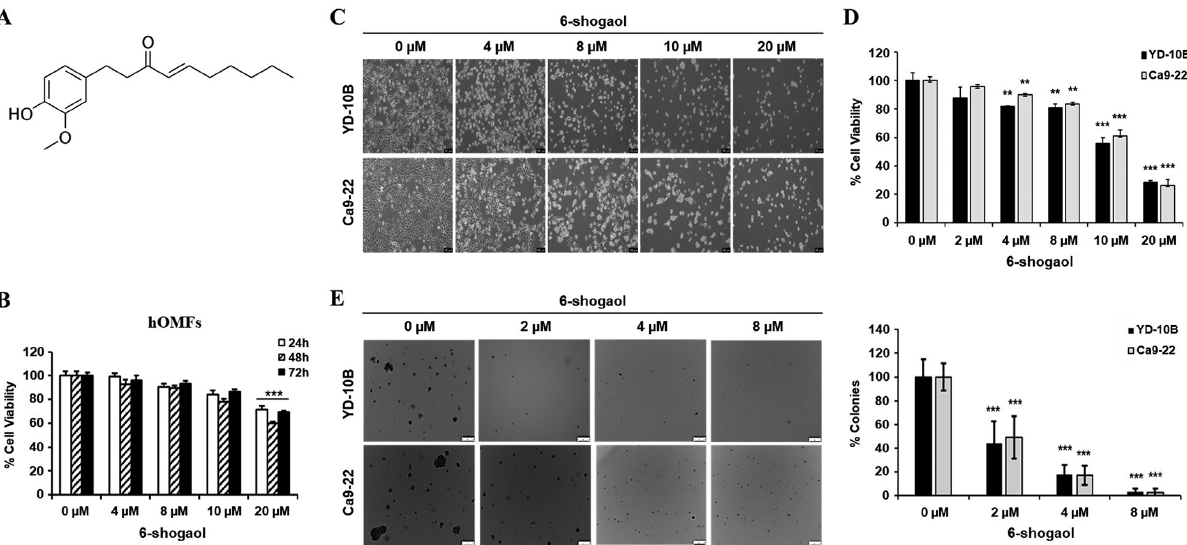
Figure 1- Effects of 6-shogaol on the growth of OSCC cells. (A) The chemical structure of 6-shogaol. (B) The toxicity effect of 6-shogaol on human oral mucosal fibroblasts at different concentrations. (C) The morphological analysis of YD-10B and Ca9-22 after treatment with 6-Shogaol (100×). (D) The viability of YD-10B and Ca9.22 cells treated with various concentrations of 6-shogaol for 24 h using MTT assay. (E) In colony formation assay, representative photographs and quantitative graphs of colonies formed on soft agar from YD-10B and Ca9-22 cells treated with 0, 2, 4, and 8 μM 6-shogaol. Data are expressed as the mean ± SEM. * p<0.05, ** p<0.01, and *** p<0.001 versus control (0 µM